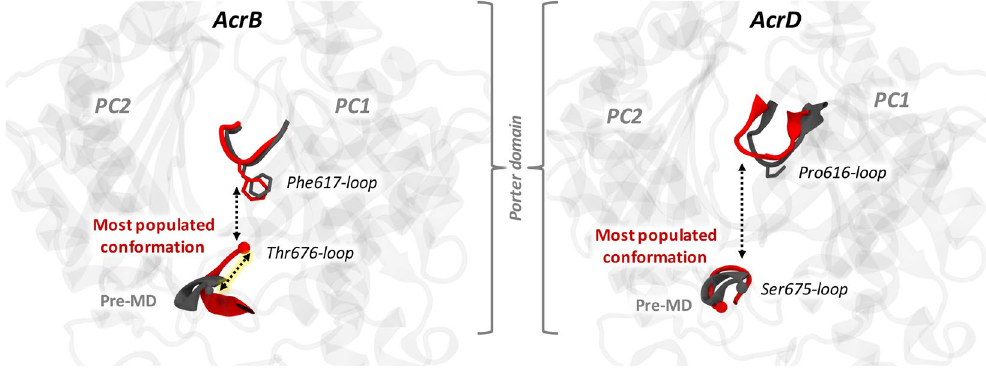
Figure 10. Main conformational states of the Thr676-loop (bottom-loop) in the Loose protomer of AcrB (left panel) and of the corresponding Ser675-loop in AcrD (right panel). The conformation of the most populated clusters and the pre-MD structures are shown in red and grey cartoons, respectively. The conformations of the G-loop are also indicated with the same colour